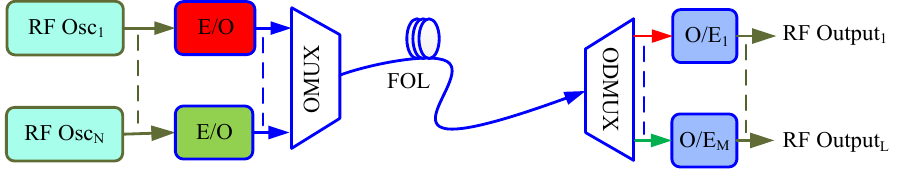
Fig. 2. Block diagram of a microwave optics frequency converter (RF Osc – radio frequency oscillator, E/O - electro-optical modulator, O/E - optoelectronic receiver, OMUX - optical multiplexer, ODMUX- optical demultiplexer, FOL - fiber-optic communication